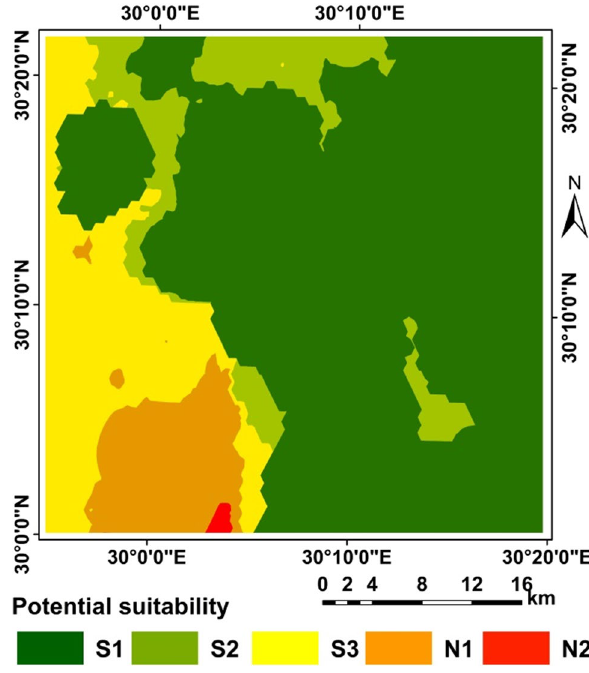
Figure 10. Potential suitability based of the suggested approach.